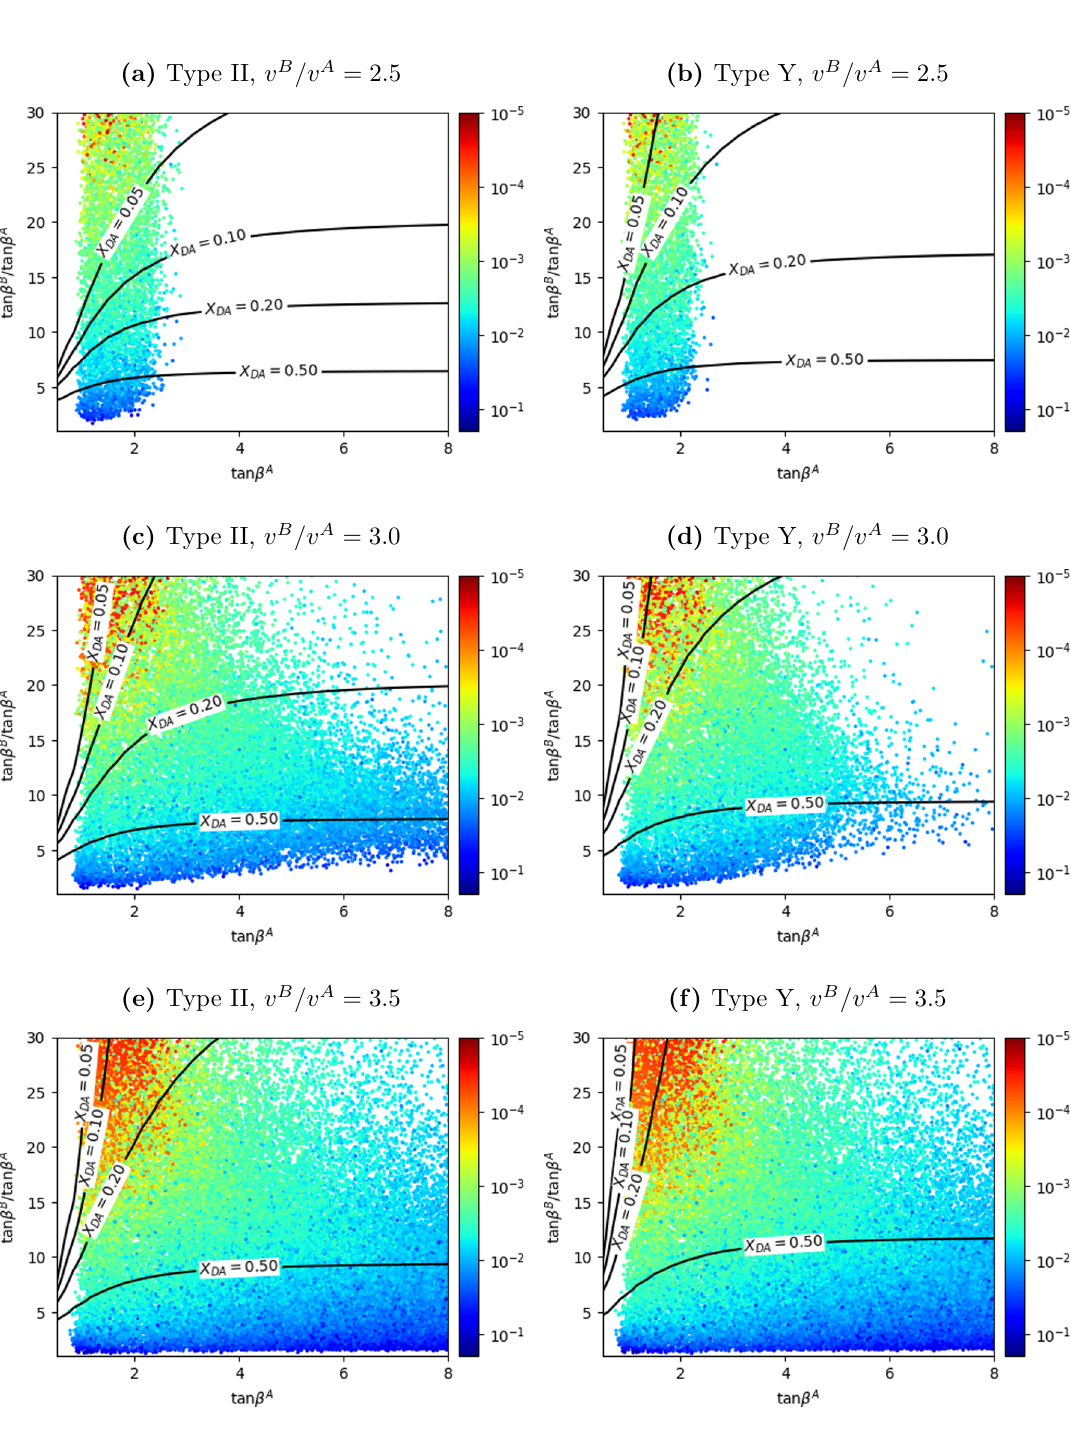
Figure 2. Contours of constant X DA for di(cid:11)erent v B =v A , di(cid:11)erent types, r T = 0 : 45 and m = 2 : 16 MeV. The colour corresponds to the minimum of T (cid:18) u A